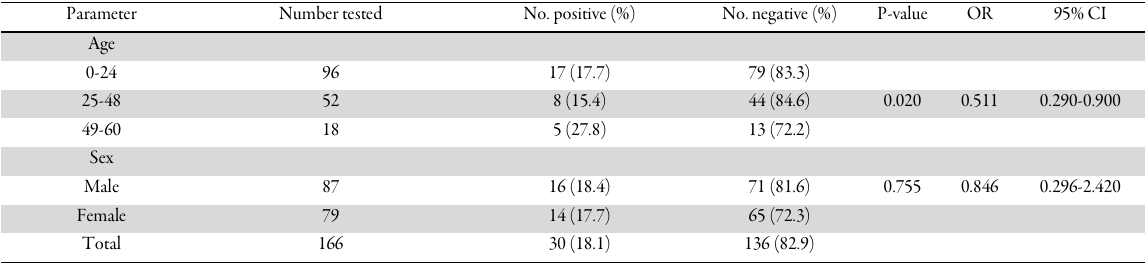
Table 1. Prevalence of Rotavirus group A infection in diarrheic children in relation to age and sex in Yobe state, Nigeria Parameter